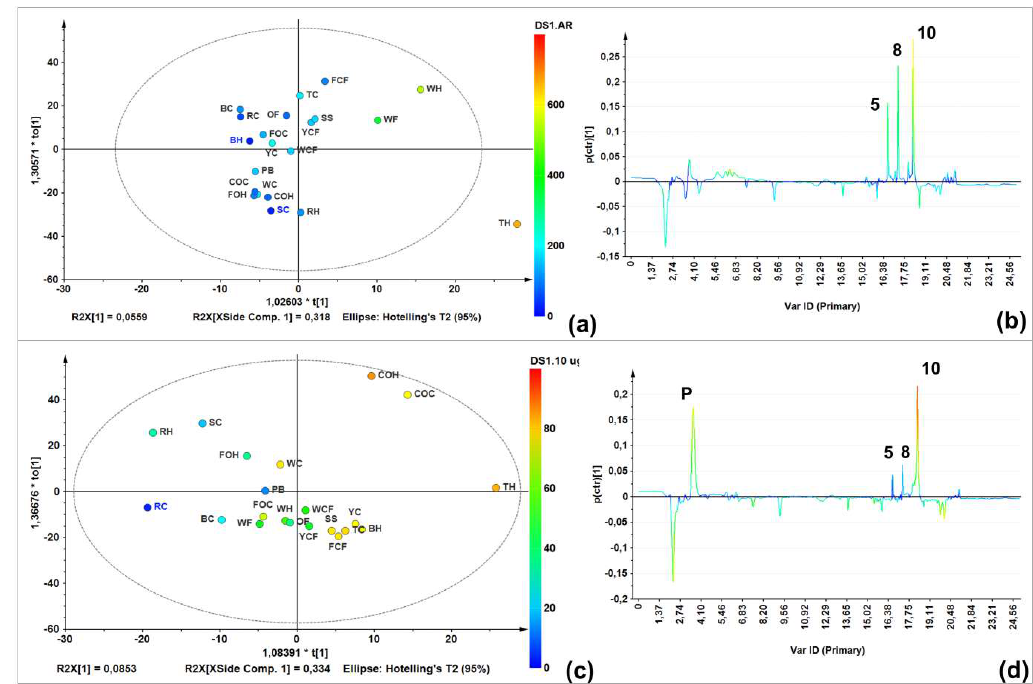
Figure 3. Targeted analysis using supervised statistics (biochemometrics). ( a ) Single-Y orthogonal partial least-squares regression (OPLS)-derived score plot on LC-MS (in negative ion mode) data using total AR content (TARC) as supervision variable; ( b ) S -line projection on LC-MS (in negative ion mode) data and TARC values; ( c ) Single-Y OPLS-derived score plot on LC-MS (in negative ion mode) data using antifungal activity at 10 µg/µL as supervision variable; and ( d ) S -line projection on LC-MS (in negative ion mode) data and antifungal activity at 10 µg/µL.